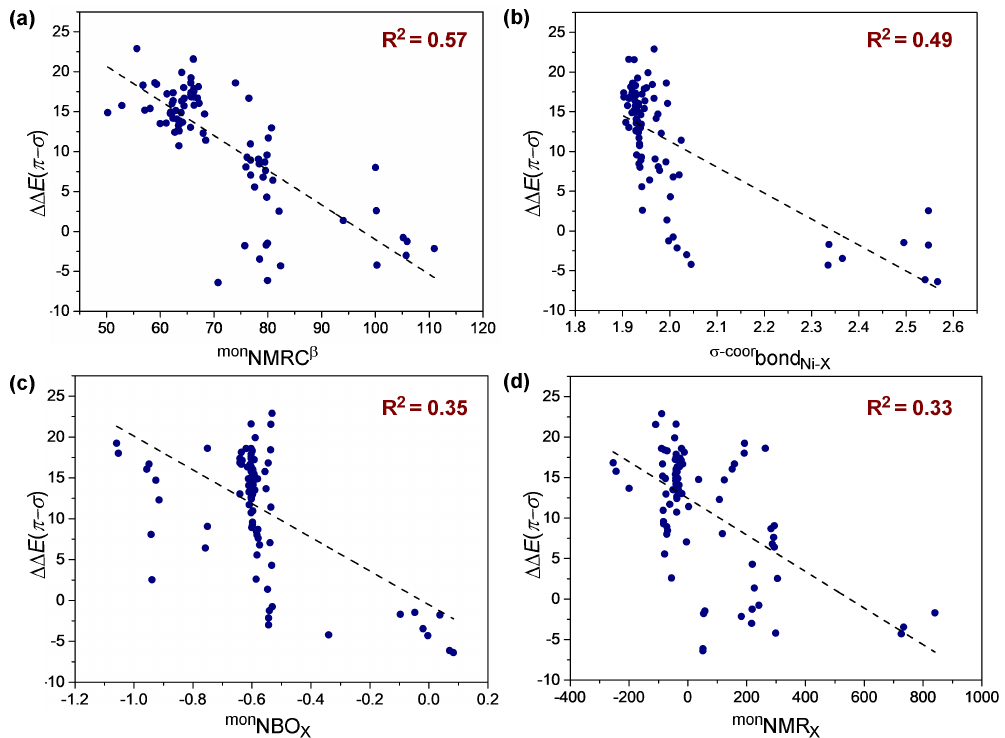
Figure 4. Representative univariate trends. Different polar monomers catalyzed by II Ni complex.